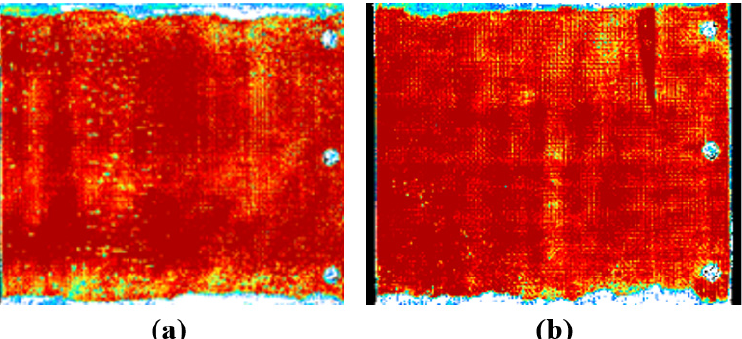
Figure 9. C-scan result of CF laminates with fiber volume content ( a ) 50%, ( b ) 55%.